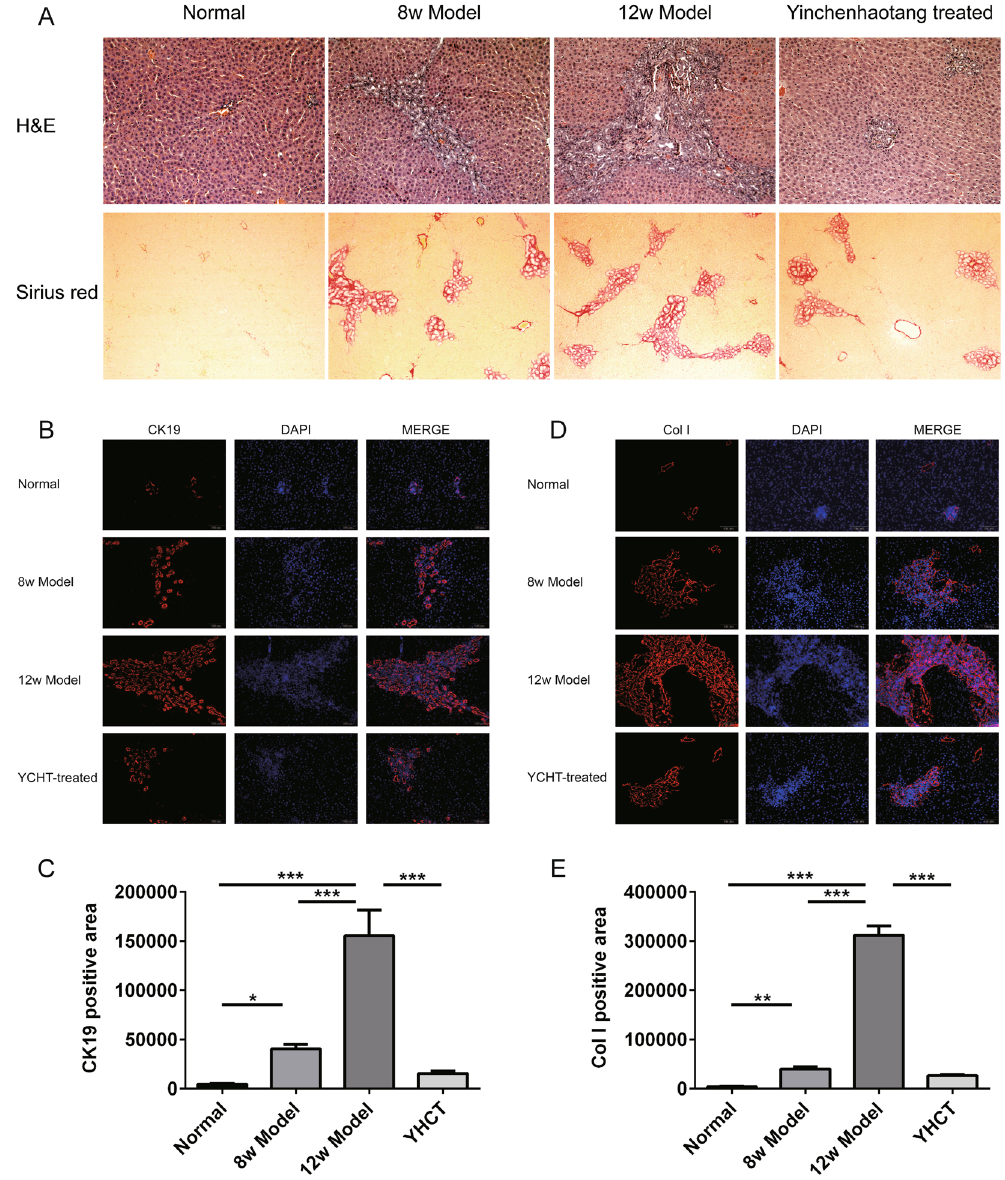
Figure 2. Histological features of ANIT-induced cholestasis model. ( A ) H&E and Sirius red stained liver sections from normal group, 8w model group, 12w model group and YCHT-treated group. Normal, healthy rats; 8w Model, ANIT treatment for 8 weeks; 12w Model, ANIT treatment for 12 weeks; YCHT-treated, ANIT- induced cholestasis rats treated with YCHT from 9 th week to 12 th week. Original magnifications × 100 for H&E, and × 200 for Sirius red. ( B ) Immunofluorescence analysis of CK19 in liver sections. ( C ) The positive area of CK19 in different groups. ( D ) Immunofluorescence analysis of Collagen I in liver sections. ( E ) The positive area of Collagen I in different groups. * P < 0.05; ** P < 0.01; *** P <